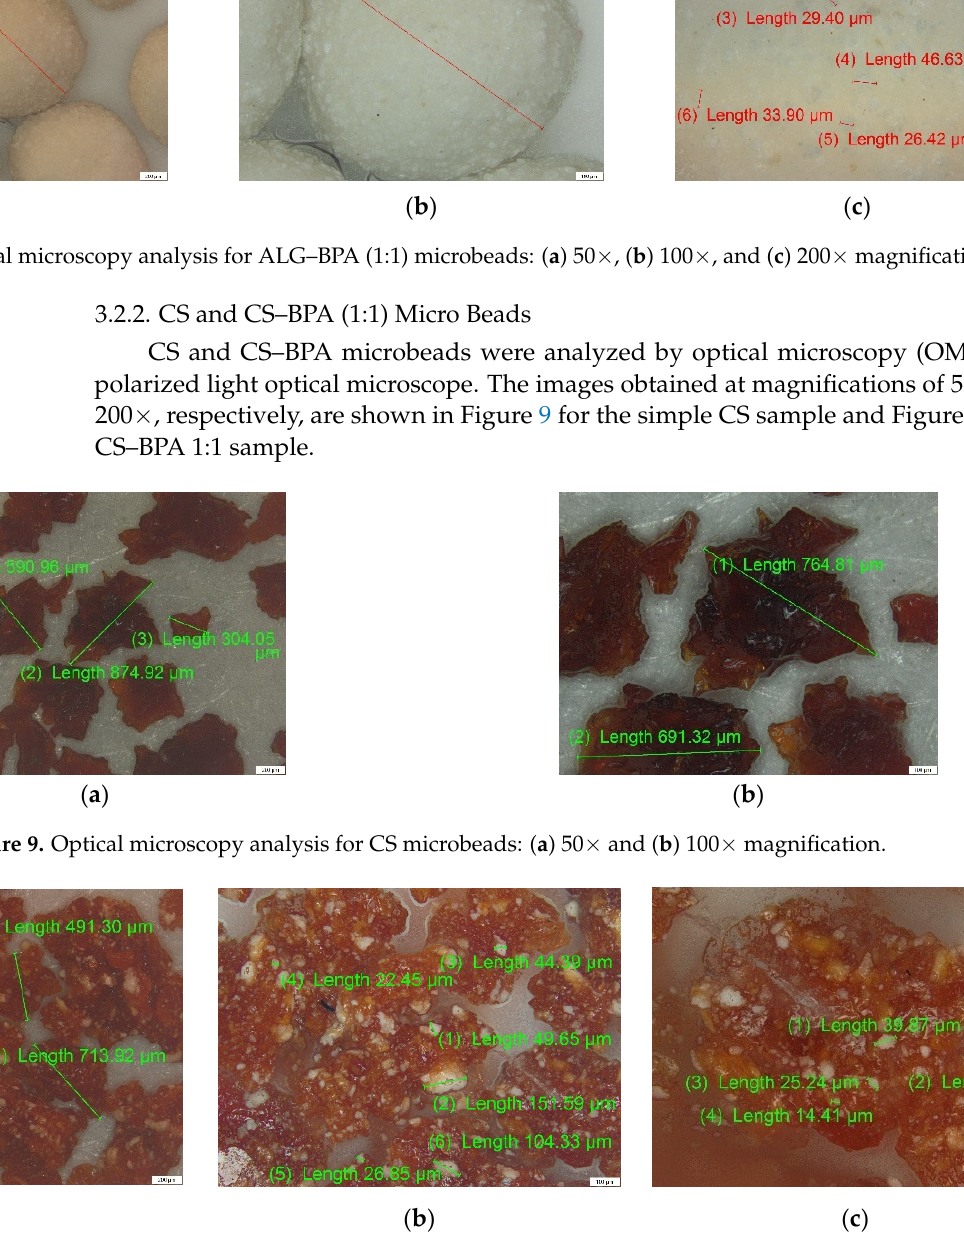
Figure 8. Optical microscopy analysis for ALG–BPA (1:1) microbeads: ( a ) 50×, ( b ) 100×, and ( c ) 200× magnification.